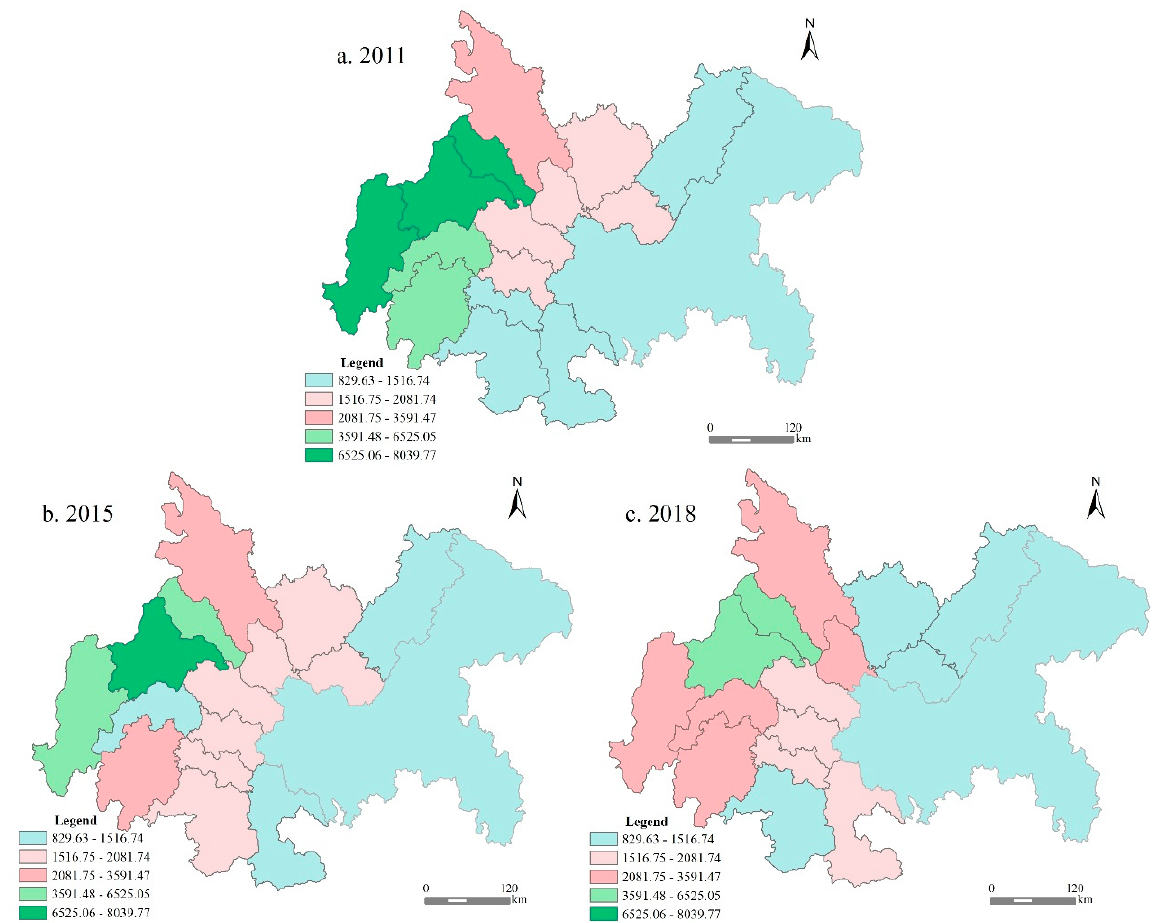
Figure 3. The spatio-temporal distribution characteristics of the matching coefficient of water and land resources in the Chengdu–Chongqing region from 2011 to 2018.